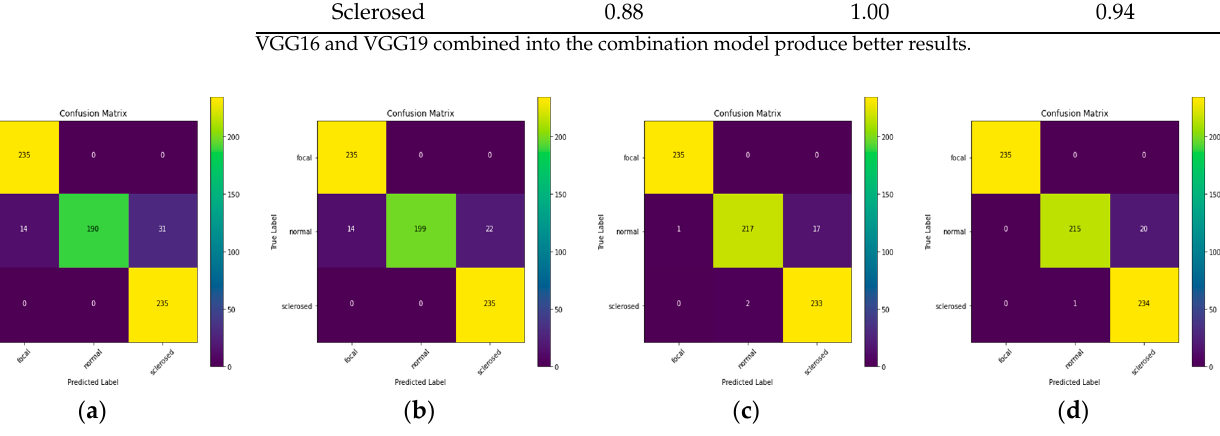
Figure 7. Confusion matrixes of combined models. ( a ) Combined model of VGG16 and VGG19 (allied model); ( b ) combined model of ResNet101, VGG16, VGG19 and EfficientNetL2 (multivariate model); ( c ) combined model of ResNet101V2 and EfficientNet-L2 (cross model) and ( d ) combined model of ResNet101V2, VGG16 and EfficientNetB7 (multivariate model).